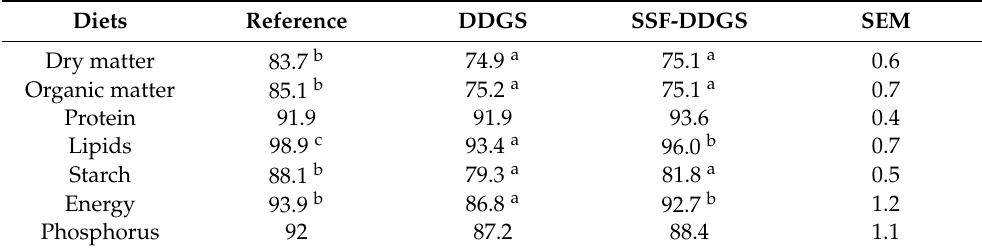
Table 4. Apparent digestibility coefficients (%) of the experimental